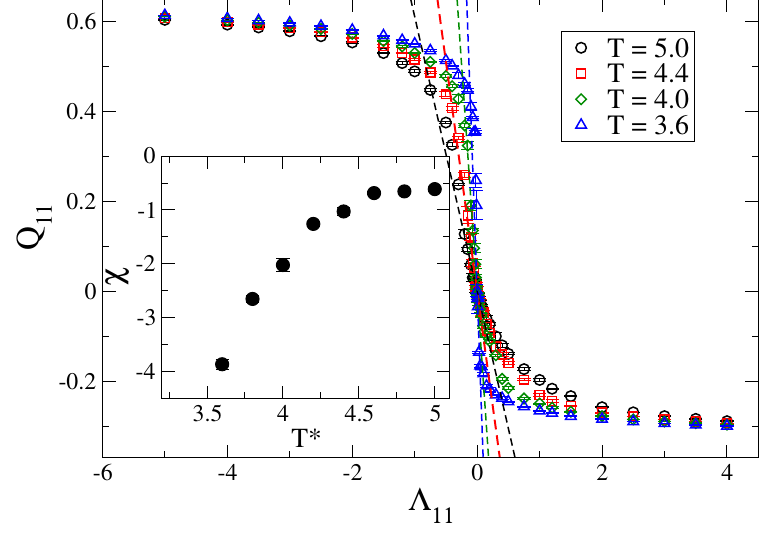
Figure 2. (Color online) The main frame shows the order parameter Q of Λ for uniaxial forms of the Lagrange multiplier. The model parameters of [30] have 11 been chosen with different temperatures in the isotropic regime. The inset shows the initial susceptibility χ as a function of reduced temperature, corresponding to the linear relation shown as broken lines in the main